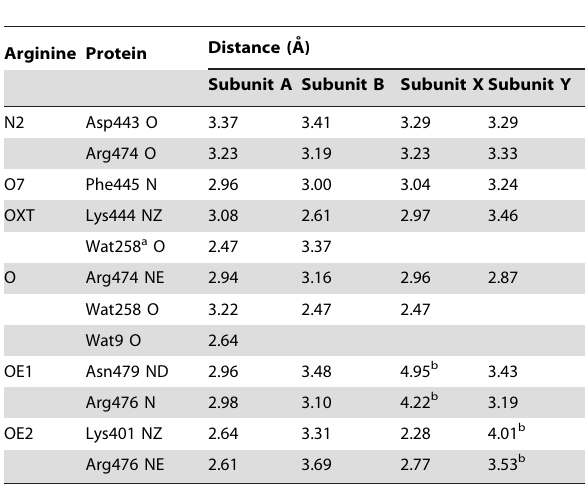
Table 3. Interactions between N -acetyl-L-glutamate and protein atoms.